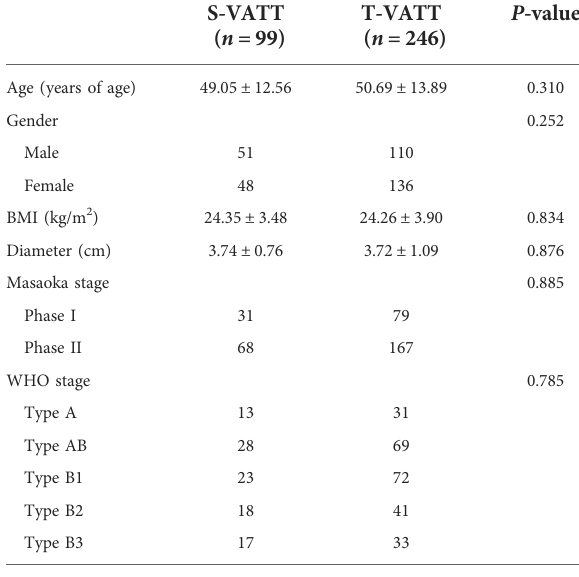
TABLE 2 Comparison of the clinical characteristics between the two groups.